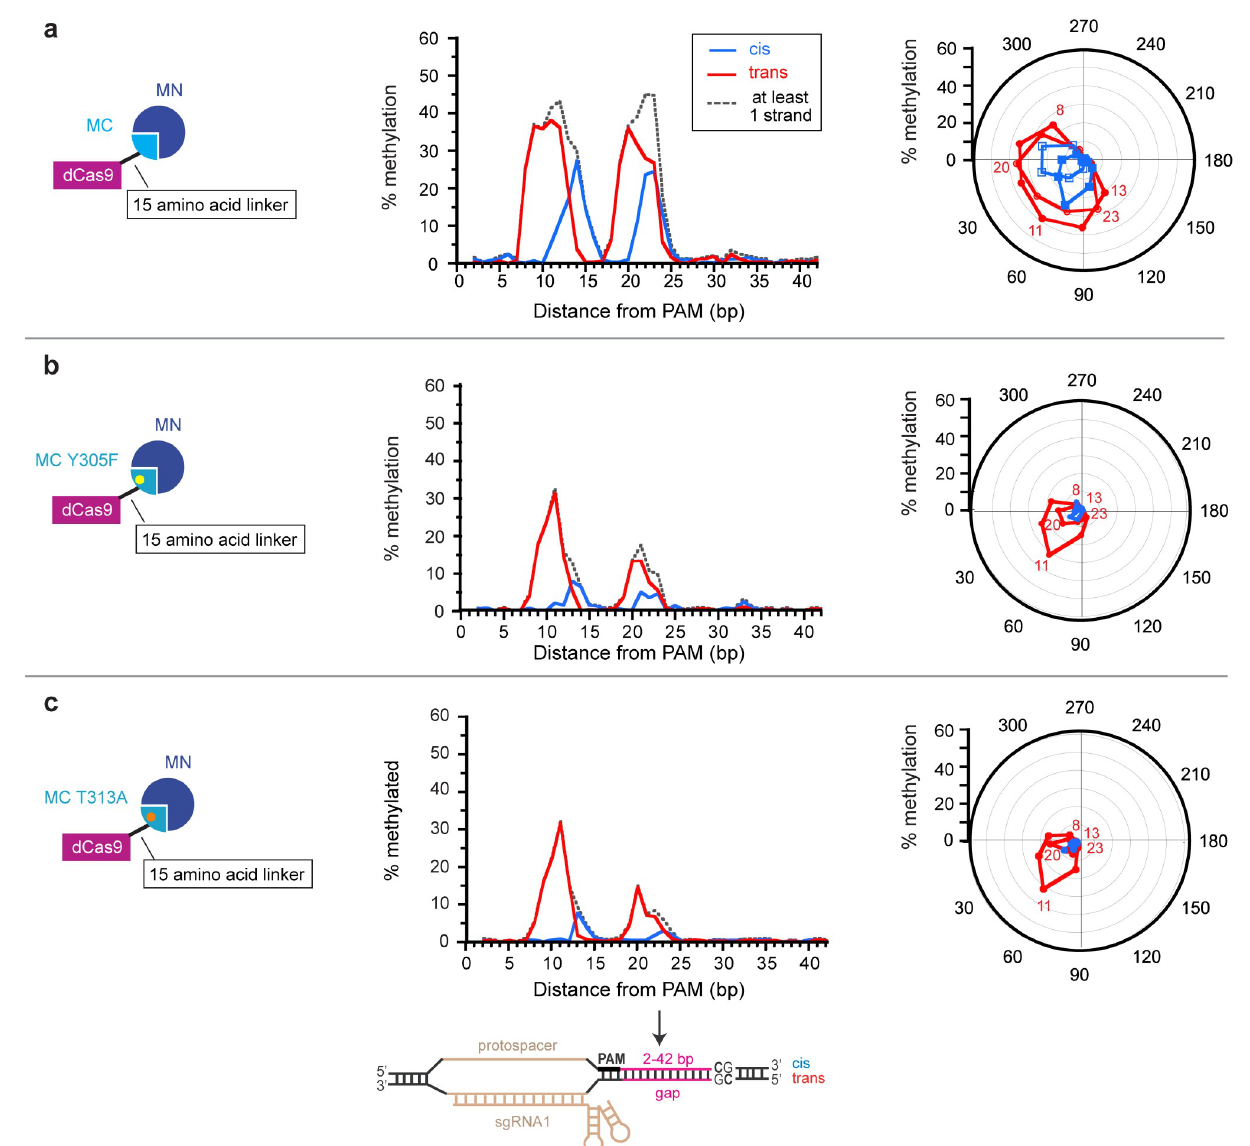
Fig 9. Effect of mutations on methylation in the target region as a function of gap length. Frequency of methylation for cis and trans strand are presented as a function of distance from the PAM (center) and the angle between the dCas9 C-terminus and the MC N-terminus (right) in the structural model for dCas9-MC/MN with a 15-amino acid linker and (a) no mutation, (b) the Y305F mutation in the MC domain, and (c) the T313A mutation in the MC domain. The angle is defined as that formed between the C-terminus of Cas9 and N-terminus of MC when looking down the DNA axis from the CpG site towards the PAM (i.e. the angle formed in the plane of the page in the view of Fig 2b and 2d). The dotted line indicates the fraction of the target sites that are methylated on at least one strand assuming that cis and trans methylation is independent. For b and c, methylation frequency data was not obtained for the trans strand for the gap lengths of 31 and 37 bp. Data in (a) is from Xiong et al. [13].